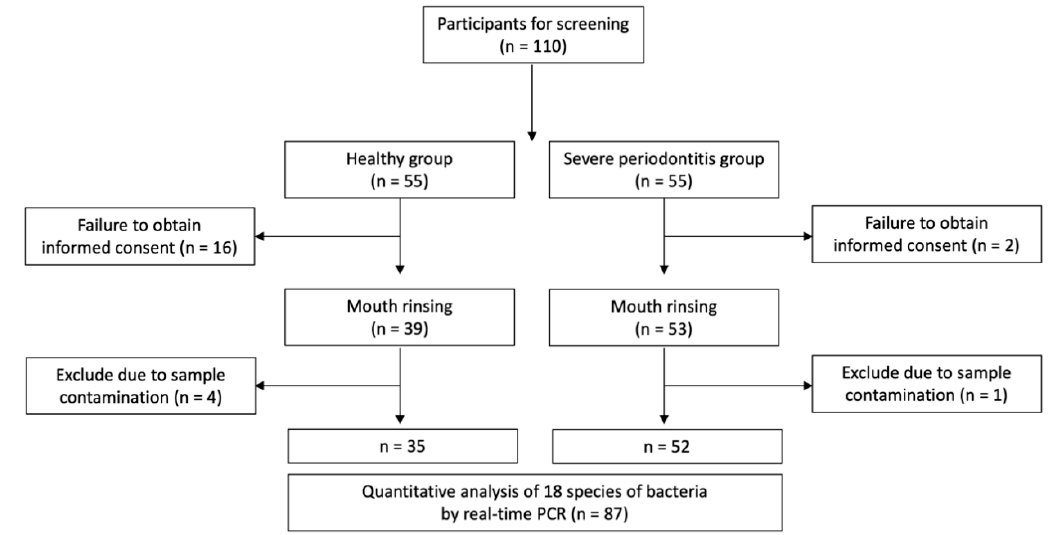
Figure 1. Study flow chart.